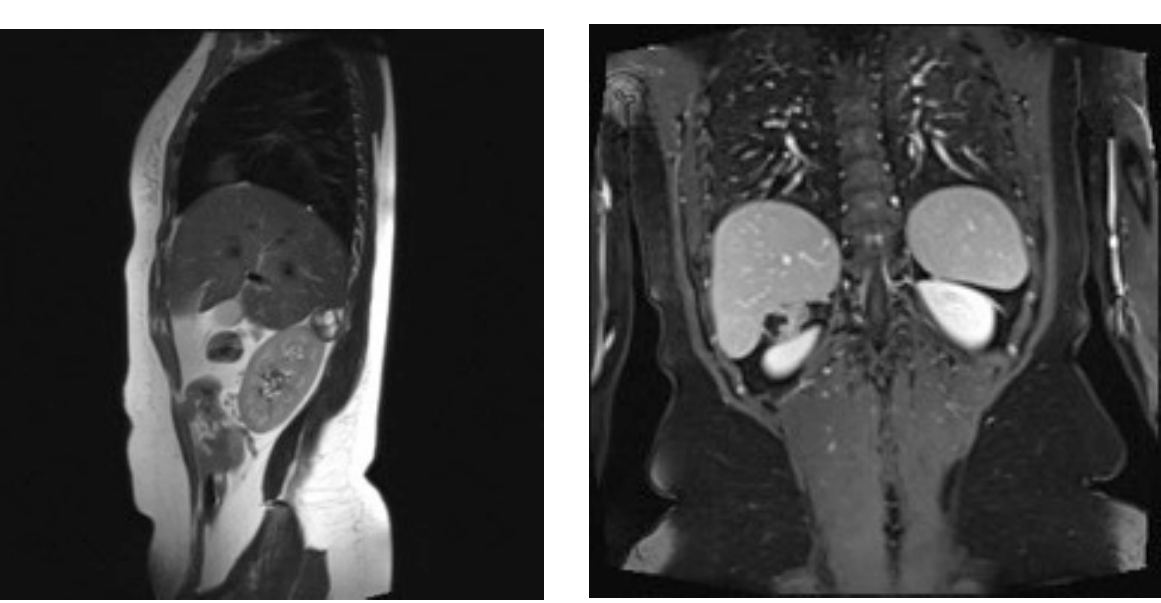
Figure 4: Rm scan T2 weighted coronal image showing the adrenal mass